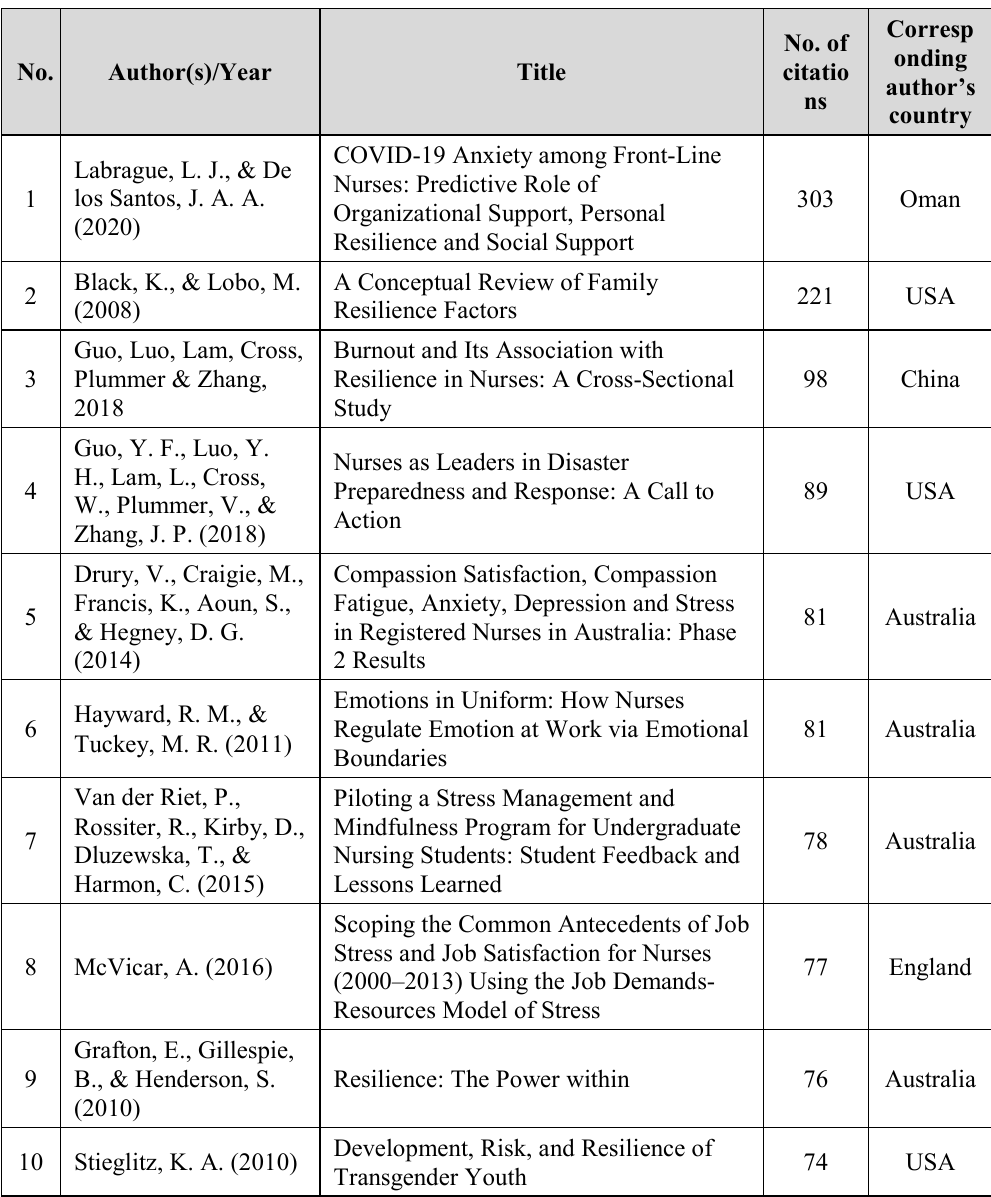
Table 2. TOP-10 Representative Papers, 2005–2022 (up to 7